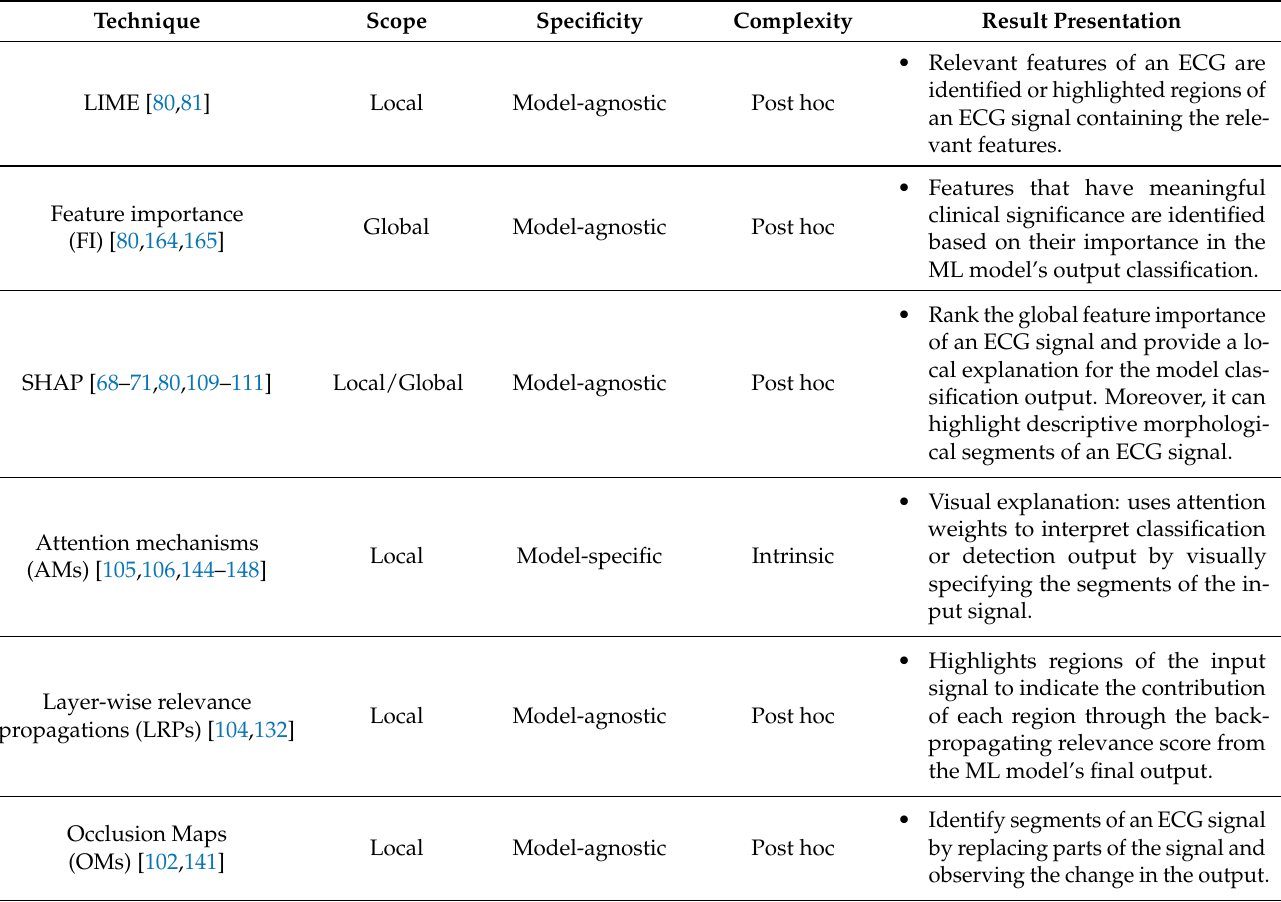
Table 6. Summary of commonly used techniques for ML interpretation in ECG-based heart dis- ease